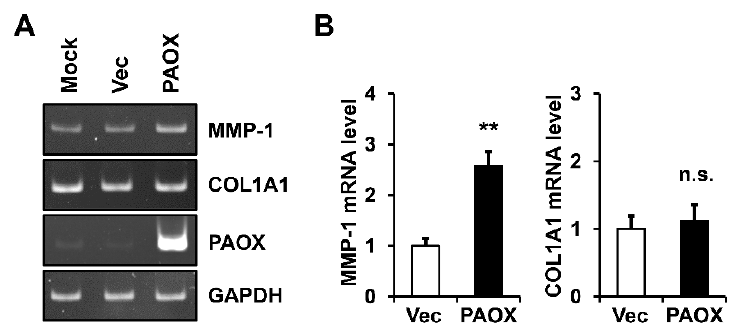
Figure 3. Effect of PAOX expression on MMP-1 messenger ribonucleic acid (mRNA) levels in fibro- blasts. Fibroblasts mock-infected or infected with vector viruses or PAOX viruses were incubated in a serum-free DMEM for 12 h. Levels of MMP-1, COL1A1, PAOX , and GAPDH mRNAs were as- sessed using ( A ) conventional and ( B ) real-time reverse transcription polymerase chain reaction (RT-PCR) analyses. Graphs depict the relative levels of MMP-1 and COL1A1 mRNAs versus vector- infected cells, obtained using real-time RT-PCR analysis. Each value represents the mean ± standard deviation of three independent experiments. ** p < 0.01 vs. vector control. n.s.: not significant.